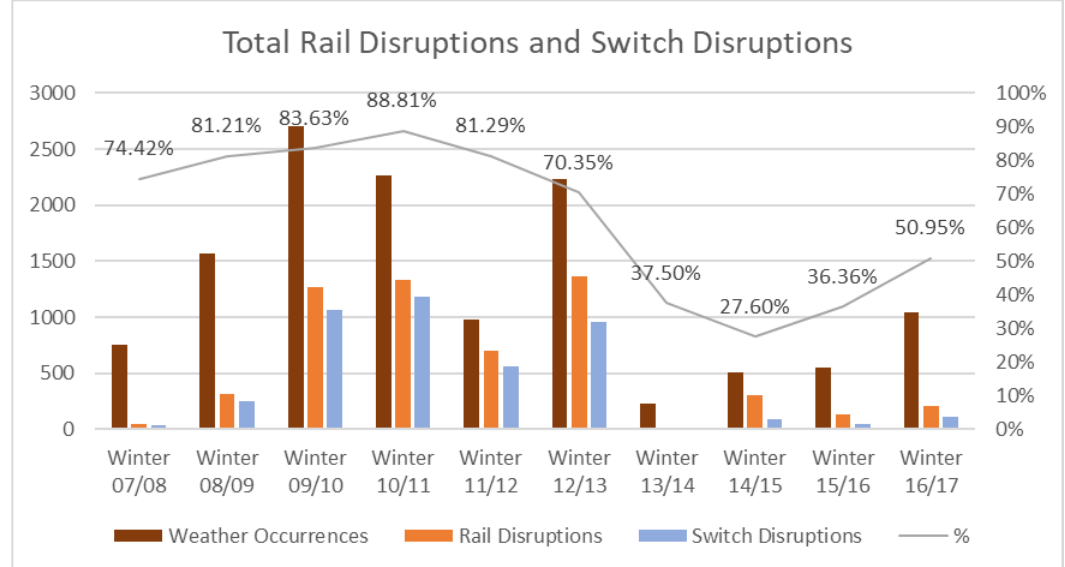
Figure 4 Distribution of rail network and switch disruptions throughout the study